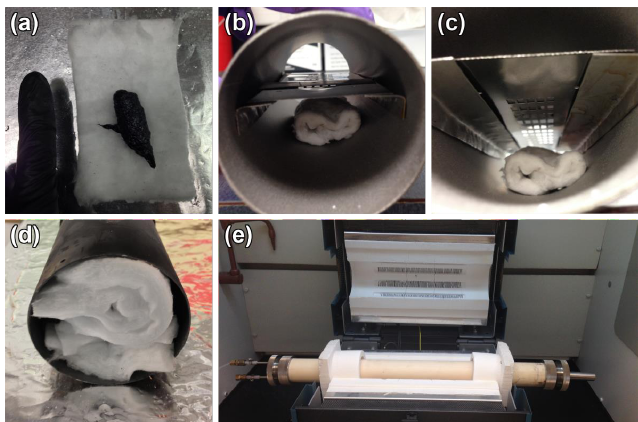
Figure 1. Graphite from the University of Idaho thermolyzed asphalt reaction (GUITAR) deposition experimental setup. ( a ) Five grams of asphalt on an alumina blanket; ( b ) alumina blanket with asphalt placed below a NS sample inside a cylindrical steel tube; ( c ) NS-coated surface faces down toward an alumina blanket; ( d ) endcaps of the cylindrical steel tube capped with the alumina blanket; ( e ) tube furnace with the N 2 inlet on the left and open exhaust on the right.